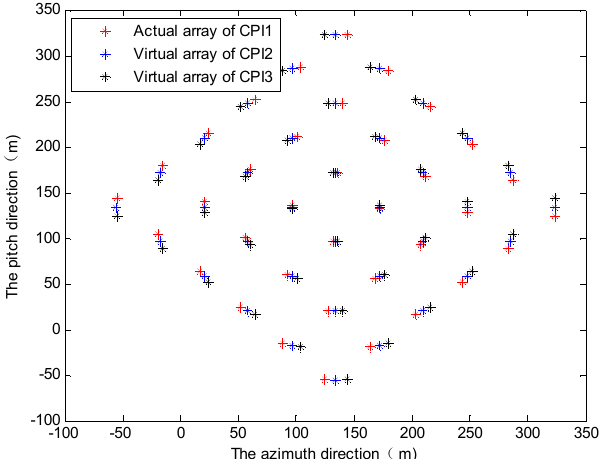
Figure 7. The virtual array diagram of distributed satellite constellation within three CPIs .